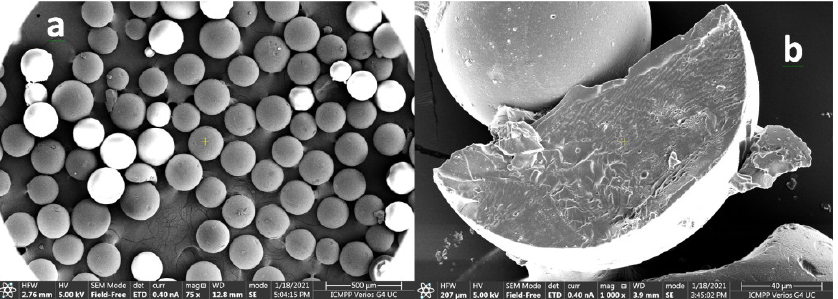
Figure 2. SEM images of dextran microparticles, magnified 74 times ( a ), microparticles in cross- section, magnified 1000 times ( b ).